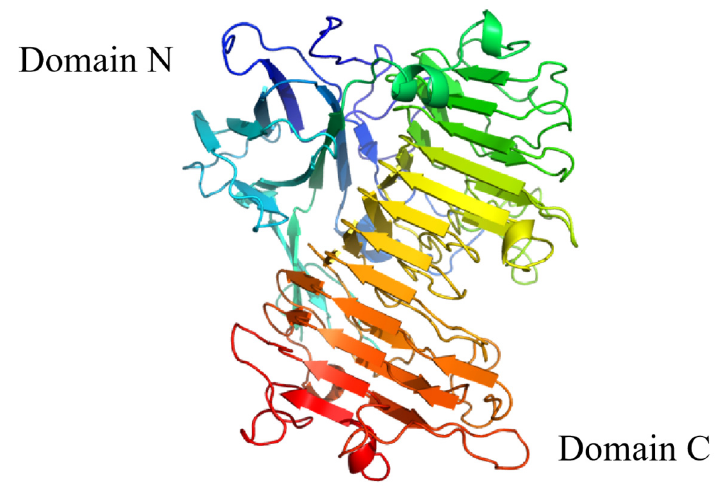
Figure 1. The 3D structure model of PsDex1711.